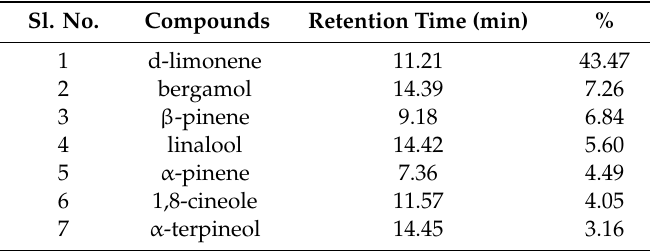
Table 4. Composition of the essential oil.